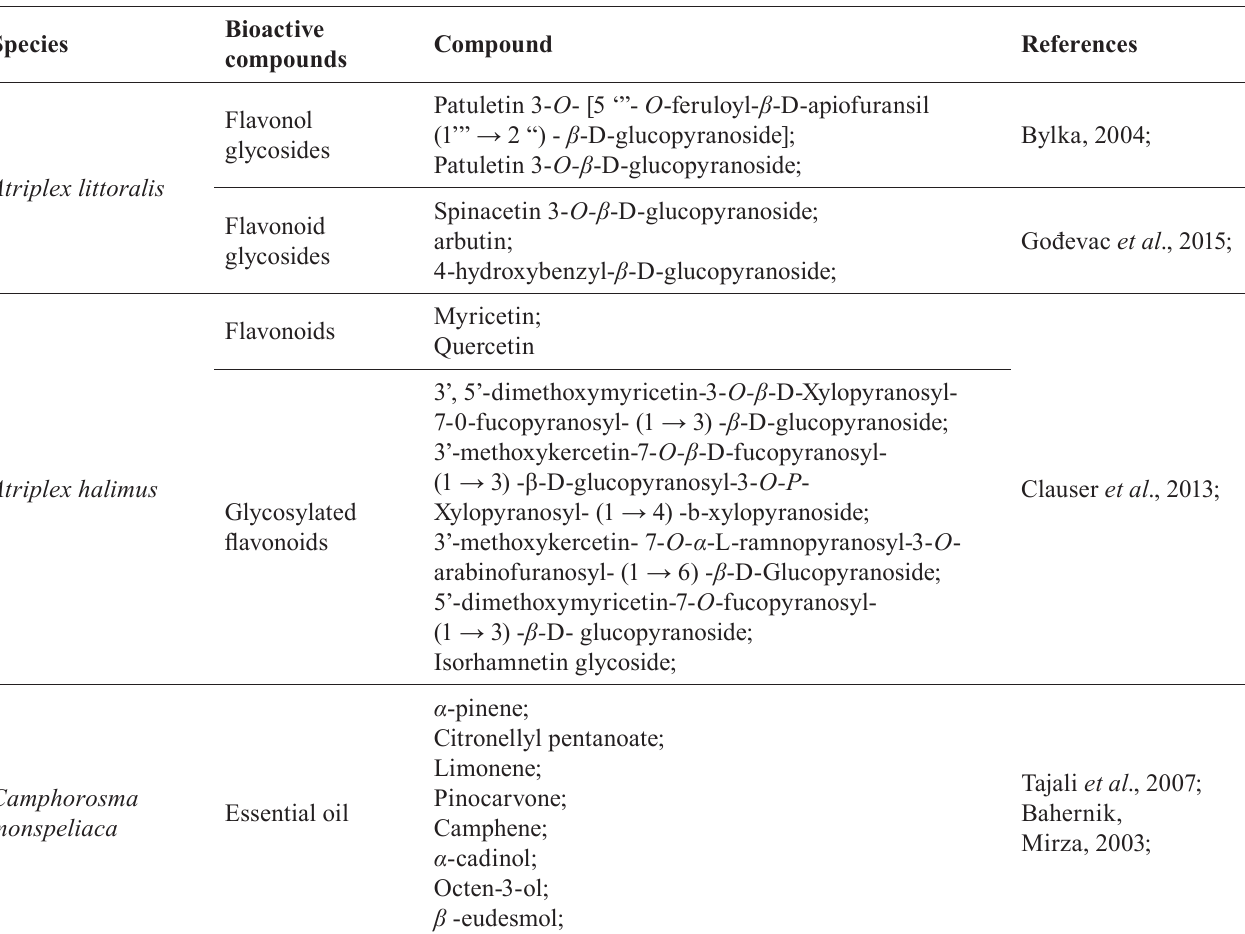
TABLE I - S econdary metabolites of presented halophytic Amaranthaceae